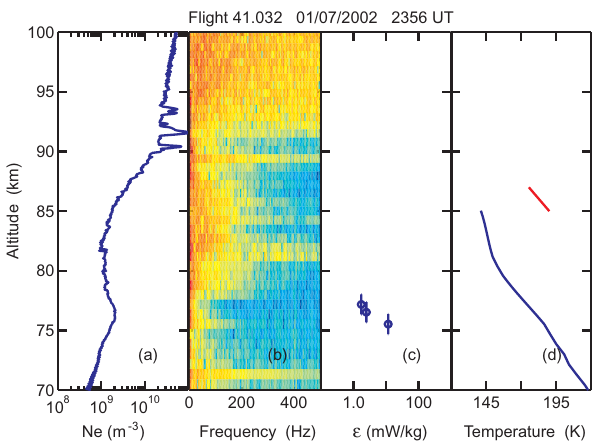
Fig. 4. Same as Fig. 2 except data obtained 1 July 2002, 23:56 UT (Flight 41.032), from Andøya, Norway.